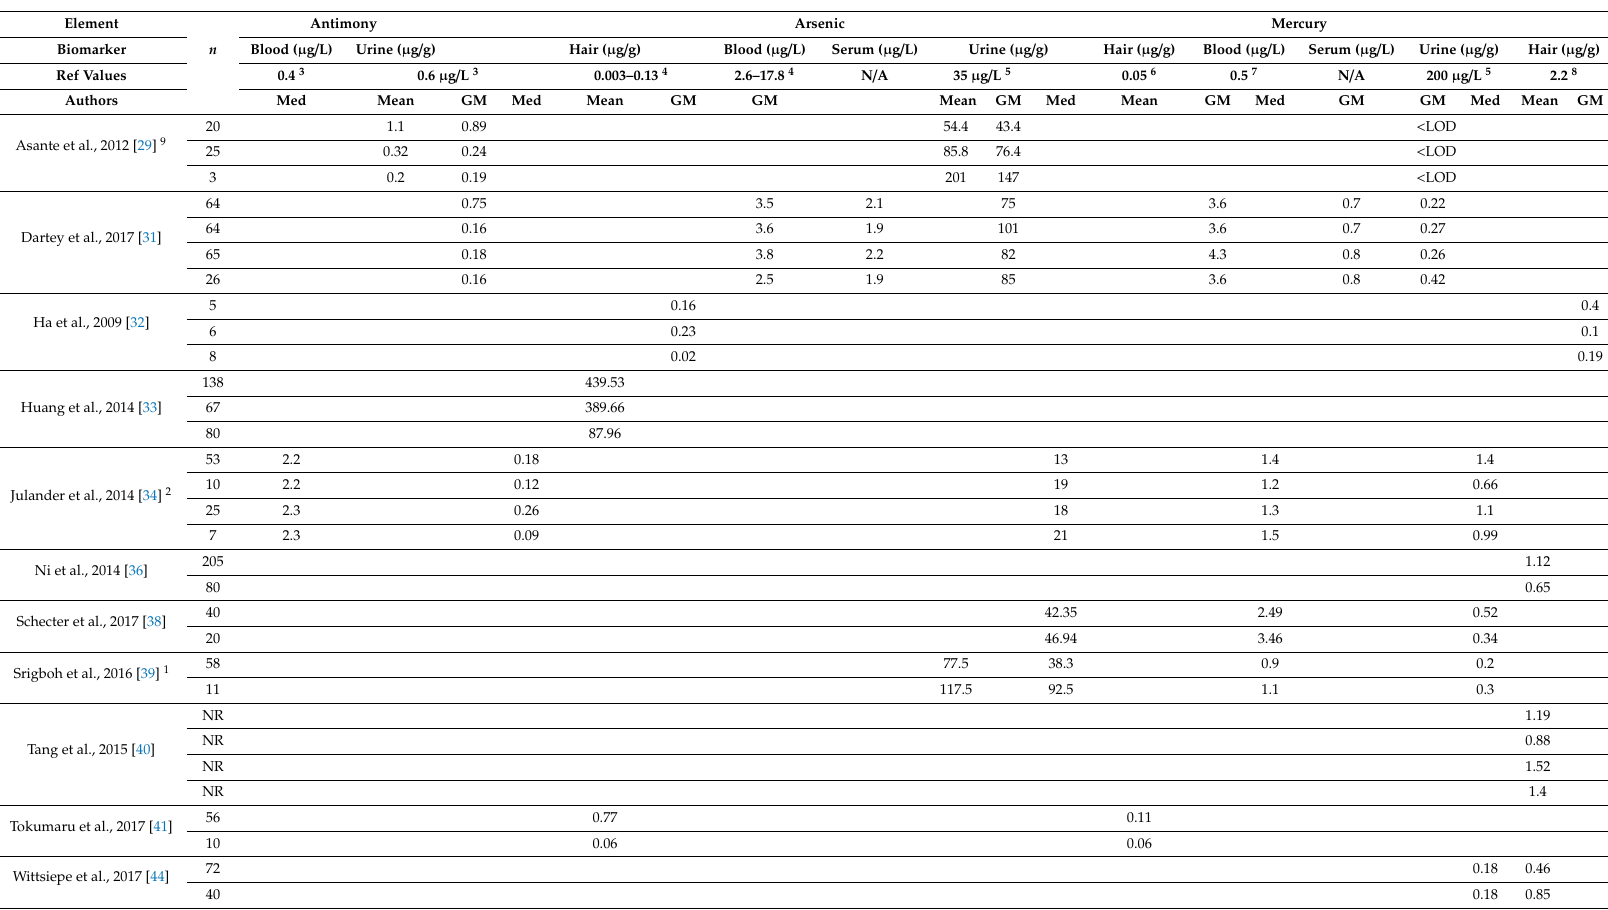
Table 6. Results of data extraction from study set for Sb, As, and Hg biomarkers in blood, serum, plasma, urine, and hair.